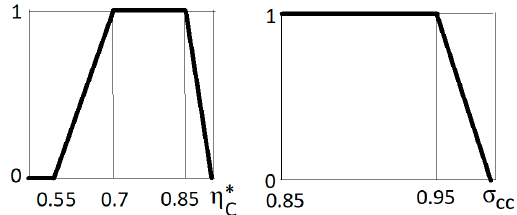
Figure 6. Examples of membership functions.